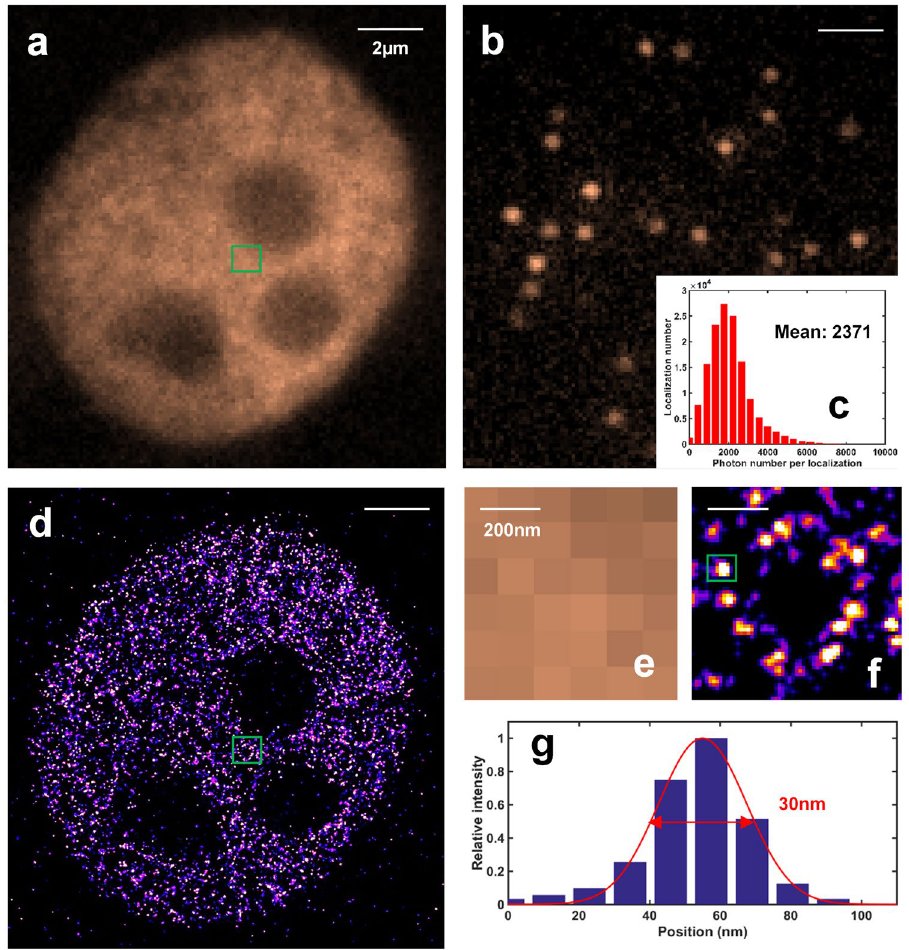
Figure 6. The performance of our low-cost SMLM imaging of acetylated H3 protein in MCF10A cells. ( a ) Conventional wide-field image. ( b ) A single raw image under d STORM imaging condition. ( c ) Statistical distribution of the photon number per localization event in this experiment. ( d ) The reconstructed super- resolution image. Pixel size: 11.5 nm. ( e , f ) are the zoomed-in region of the green box in ( a , d ). ( g ) Statistical distribution of the localization events for the selected acetylated H3 cluster in the green box of ( f